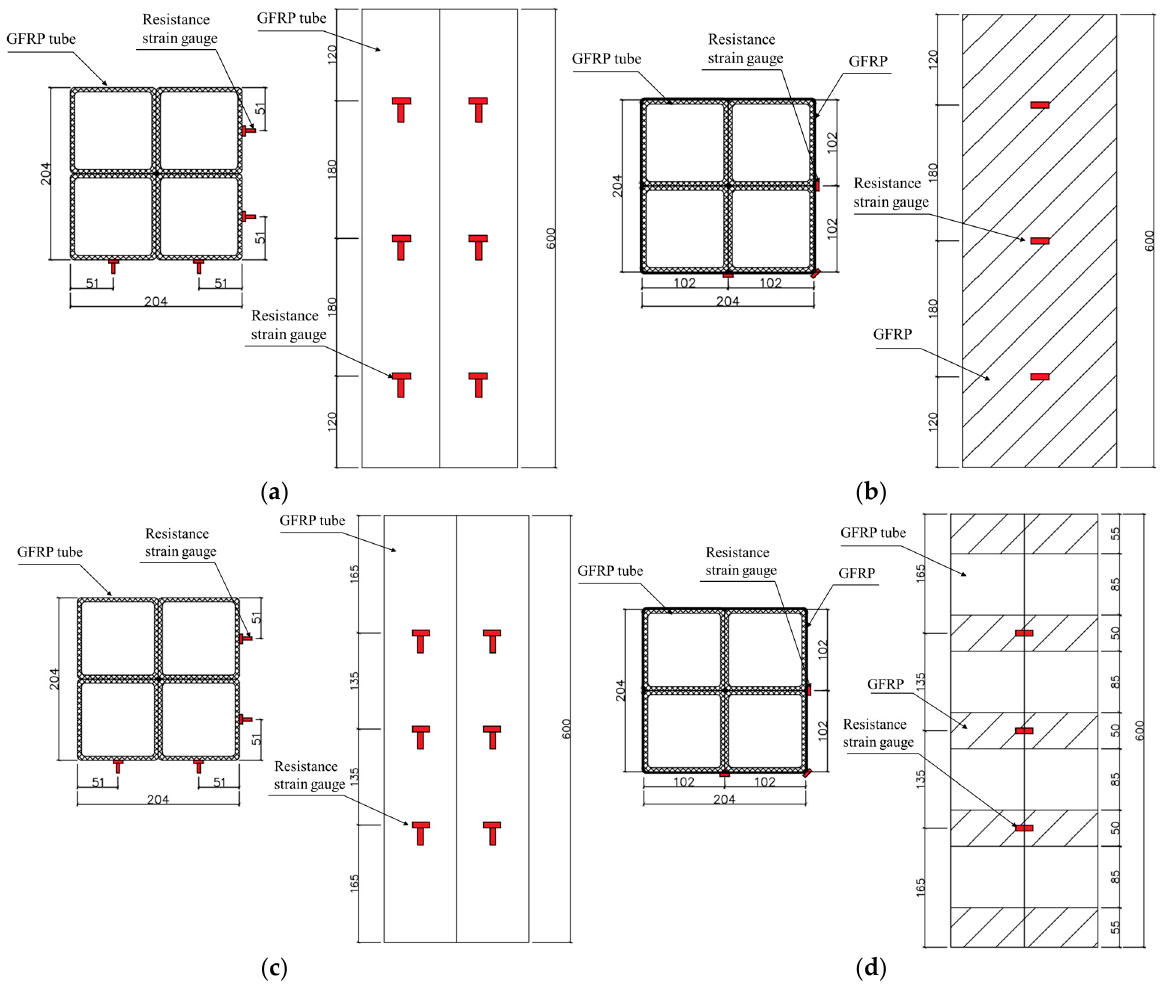
Figure 3. Location of the strain gauges: ( a ) W600S0-GFRP tube; ( b ) W600S0-GFRP; ( c ) W50S85-GFRP tube; and ( d ) W50S85-GFRP.